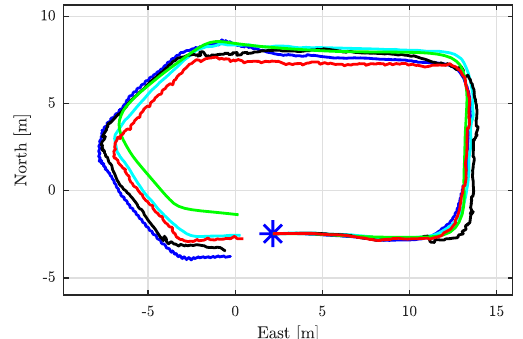
Figure 3. Estimated and reference cart trajectory: GNSS-only solution (black), RGB-D-only solution (green), GNSS/RGB-D combination (red), GNSS/RGB combination (blue), reference (cyan). The blue star represents the starting point of the trajectory.